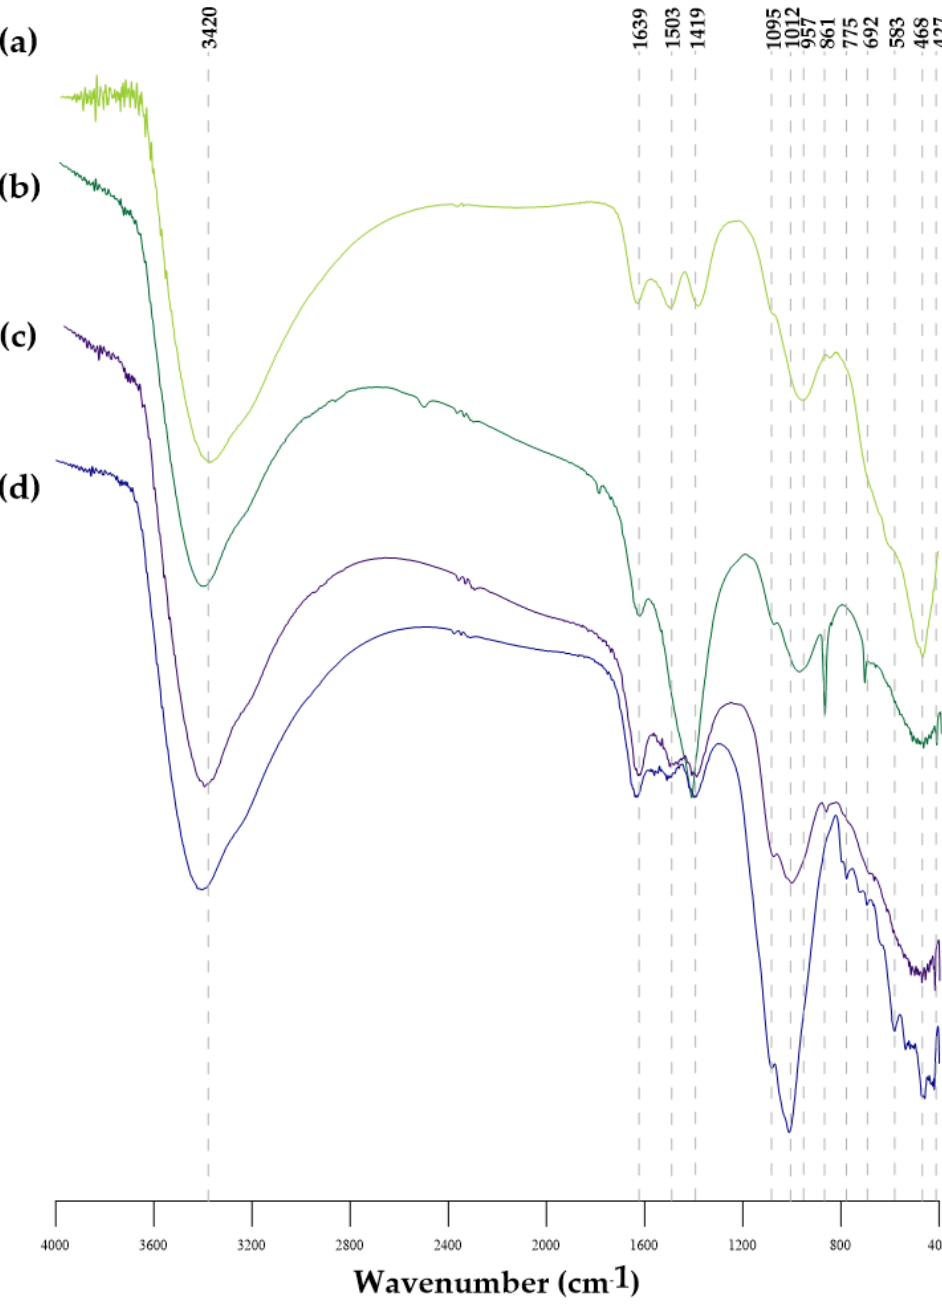
Figure 2. Fourier transform infrared (FTIR) spectra of: ( a ) GWTRa-1, ( b ) GWTRs-2, ( c ) GWTRs-3, ( d ) GWTRs-4.